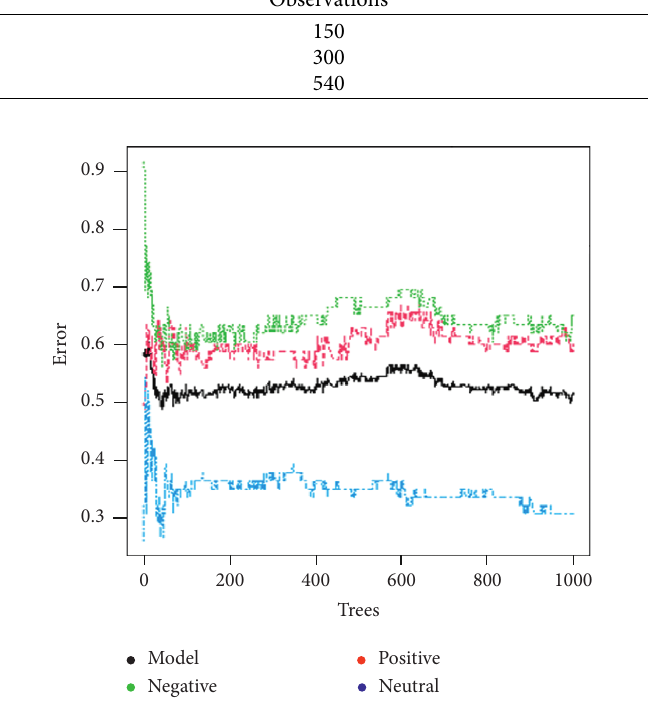
Figure 3: Random forest plot of OOB error estimates of classes. Table 2: Random forest training.